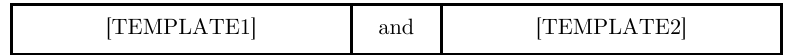
Figure 5. Meta-template which specifies that two templates can be concatenated with the word